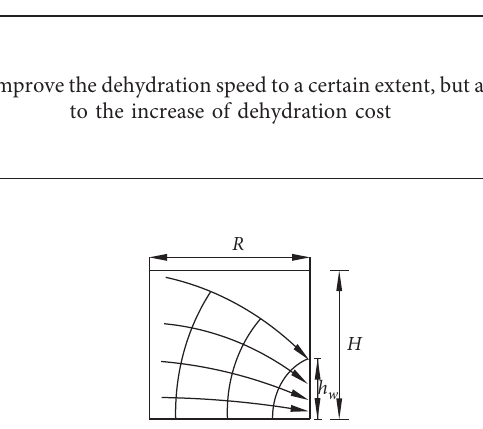
Figure 1: Schematic diagram of water flow in total tailing filling slurry.